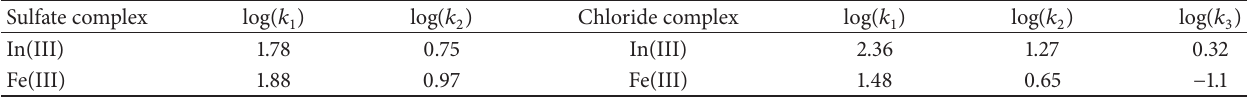
Table 1: Stability constants of Fe(III) and In(III) in sulfate and chloride media [24].